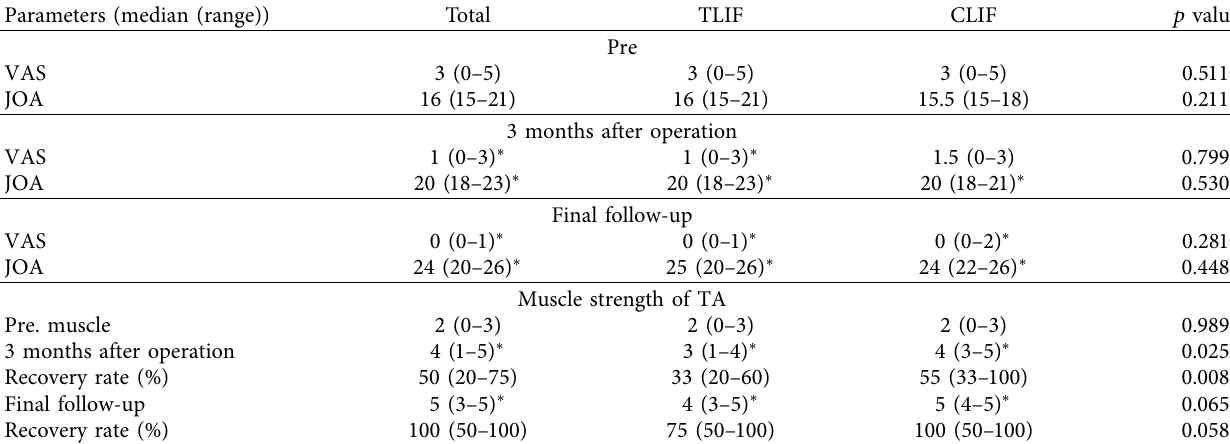
Table 2: Clinical evaluation of patients in the TLIF group and CLIF group.